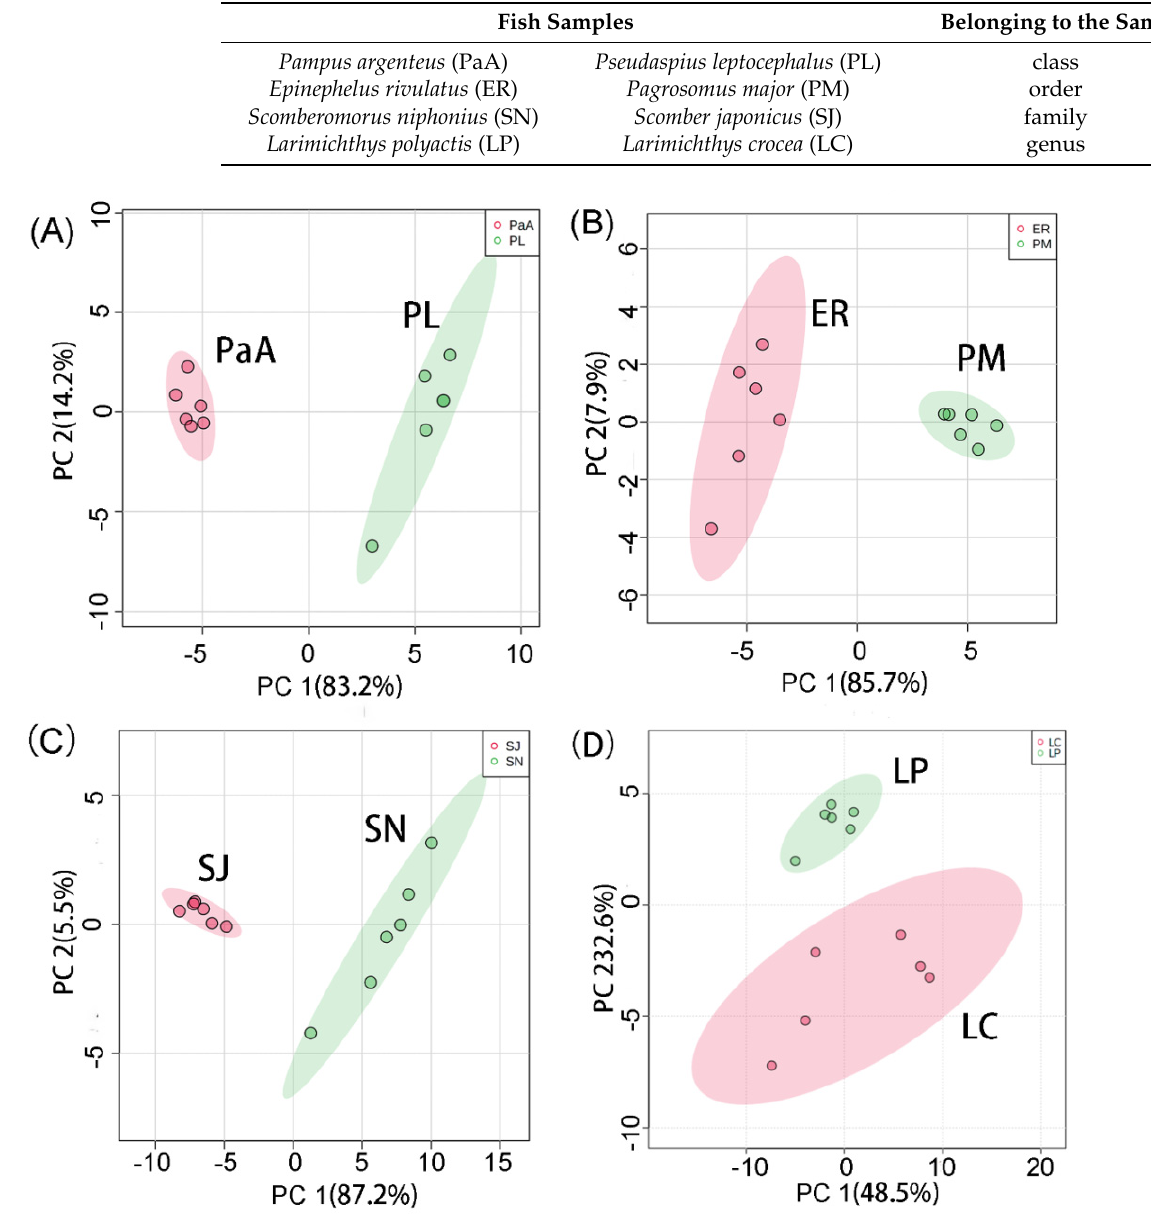
Figure 4. ( A ) Plot of principal component analysis (PCA) scores of UV-Vis spectra of Pampus argenteus (PaA) and Pseudaspius leptocephalus (PL). PaA and PL both belong to the class Actinopterygii. ( B ) Plot of PCA scores of UV-Vis spectra of Epinephelus rivulatus (ER) and Pagrosomus major (PM). ER and PM both belong to the order Perciformes. ( C ) PCA score plot of UV-Vis spectra of Scomberomorus niphonius (SN) and Scomber japonicus (SJ). SN and SJ both belong to the family Scombridae. ( D ) PCA score plot for the UV-Vis spectra of Larimichthys polyactis (LP) and Larimichthys crocea (LC). LP and LC both belong to the genus Larimichthys. Six UV-Vis spectra were obtained from each fish species. The initial extract was diluted 80-fold with deionized (DI) water for further analysis. The other conditions make reference to the information listed in experimental Section